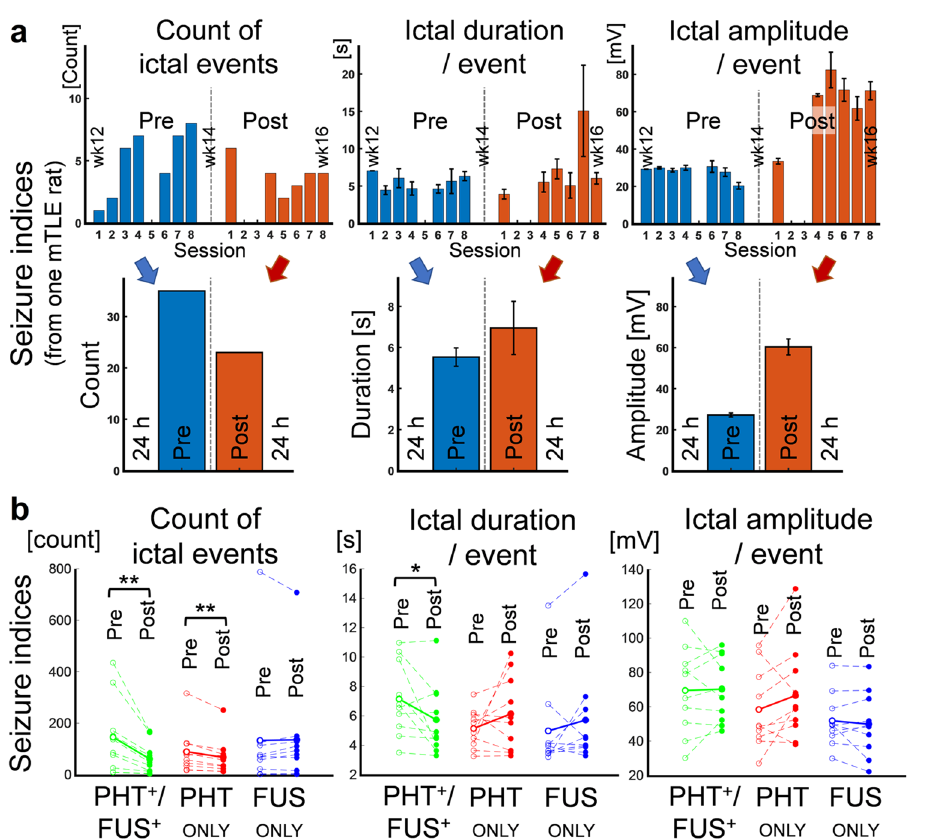
Figure 4. The change of the three seizure indices before (Pre) and during/after (Post) interventions. ( a ) 3 h-long EEG session-by-session data (upper) and 24 h pre-/post-data (lower) from the 8 EEG sessions (3 h-long each) of an exemplar mTLE rat with PHT ONLY intervention. ( b ) 24 h pre-/post-data across the PHT + /FUS + (green), PHT ONLY (red), and FUS ONLY (blue) groups (n = 10 rats/group). The dashed lines link the pre- (empty circles) and post-intervention (filled circles) values from each individual rat, and the solid lines link the mean values of the pre-/post-intervention seizure indices within each group. * p < 0.05, ** p < 0.01 (paired t -test,